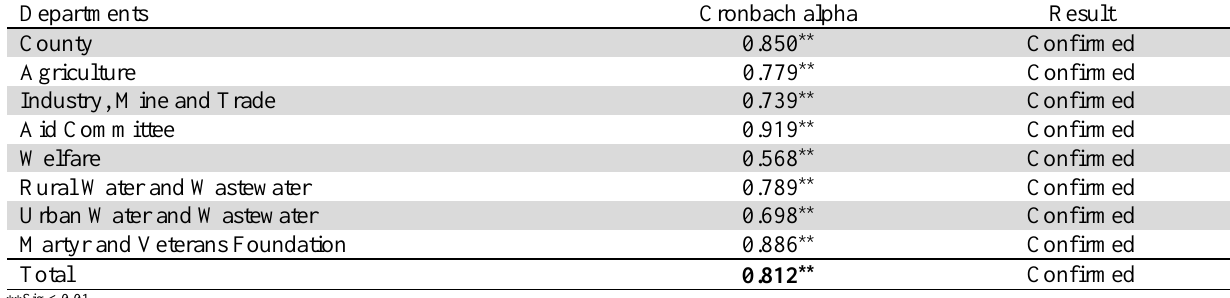
Correlation test between corporation stability and consistency and organizational success in all departments of Khorasan